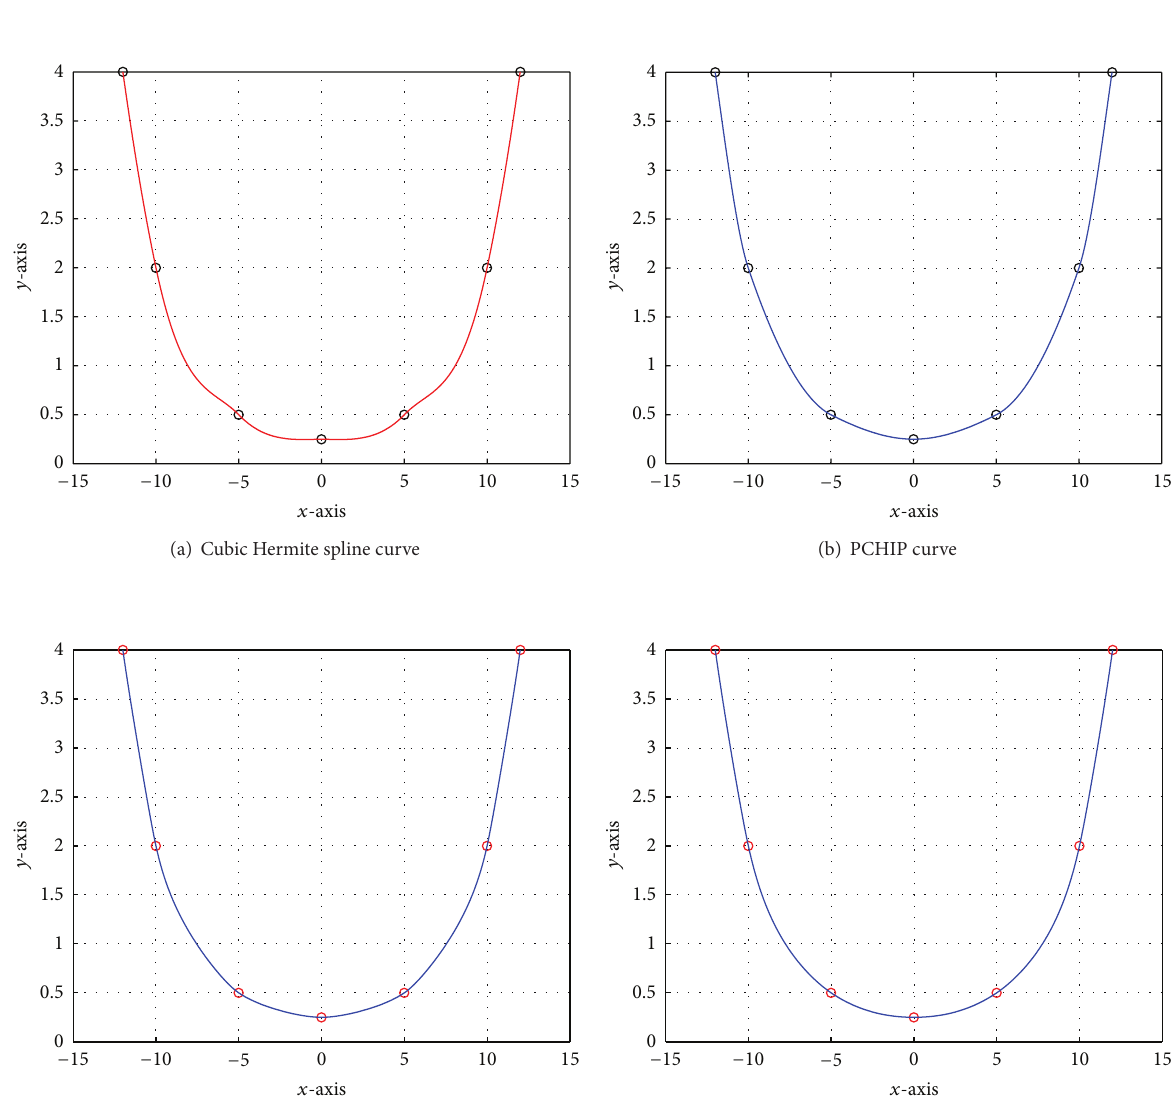
(d) Convexity-preserving rational cubic curve with 𝑢 𝑖 = 1.5 , V 𝑖 = 1.5